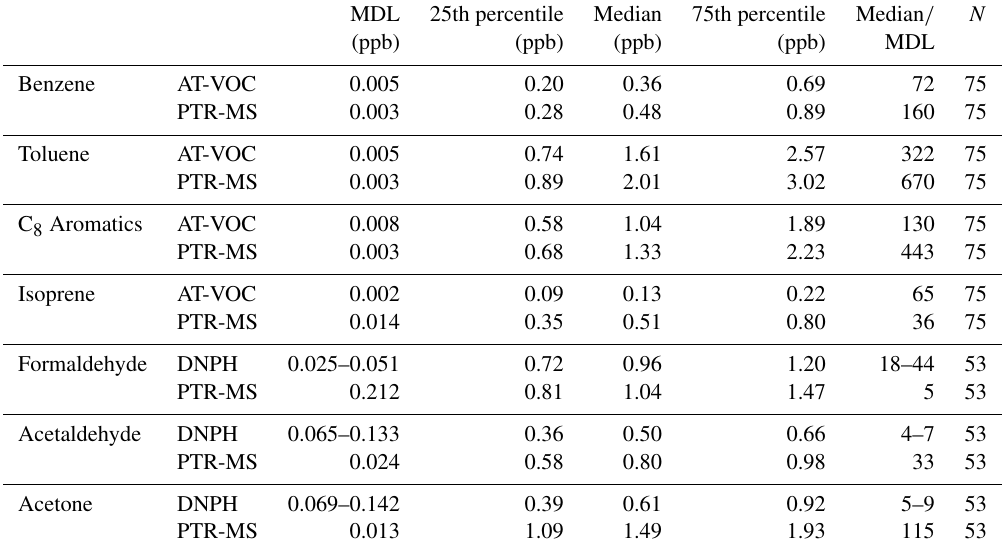
Table 3. The MDL and summary statistics (ppb) for the PTR-MS, AT-VOC and DNPH data for each of the seven compounds selected for this study. Note that the DNPH MDL differs between morning afternoon and night samples due to different sampling times result. For the purposes of this table the DNPH MDLs and median/MDLs are quoted as a